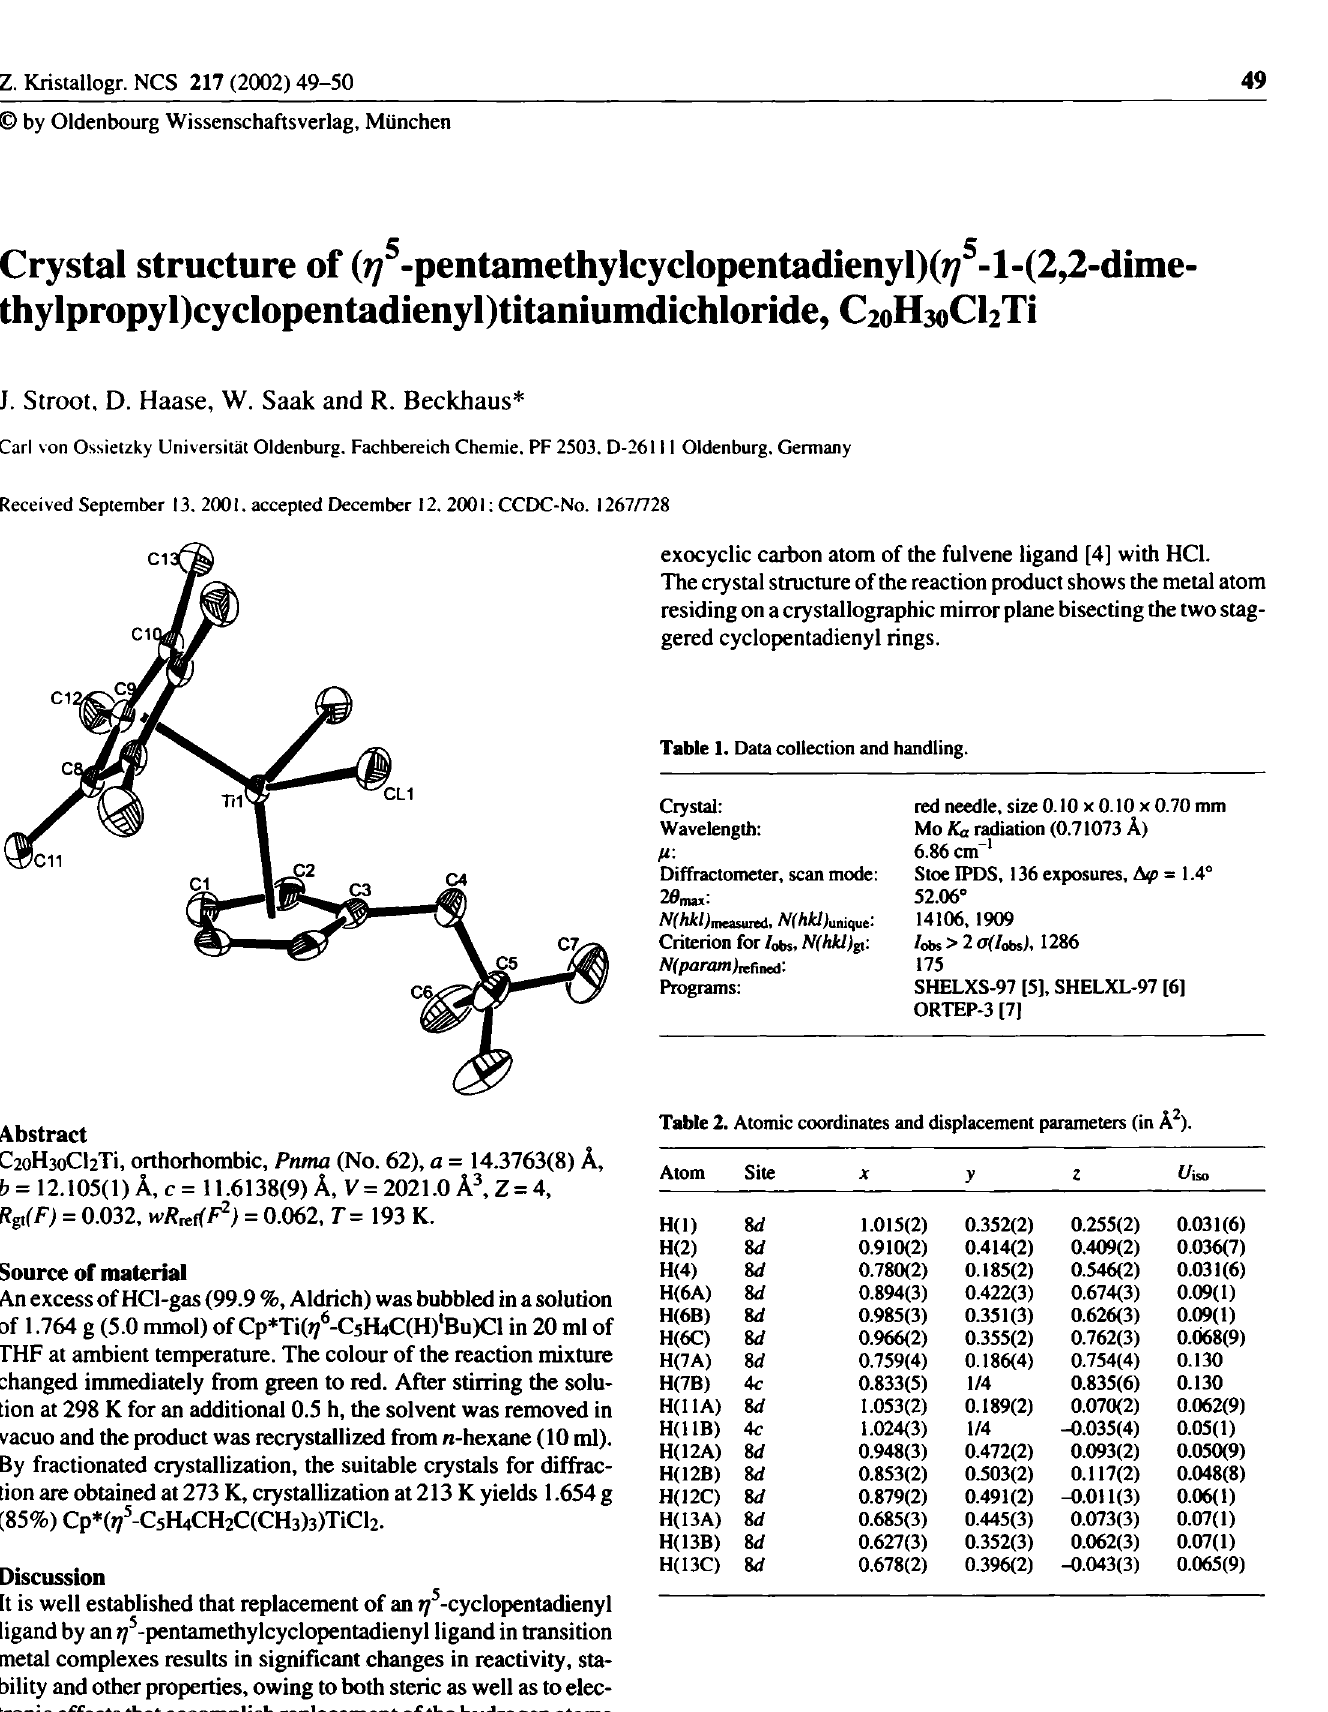
Table 2. Atomic coordinates and displacement parameters (in Â 2